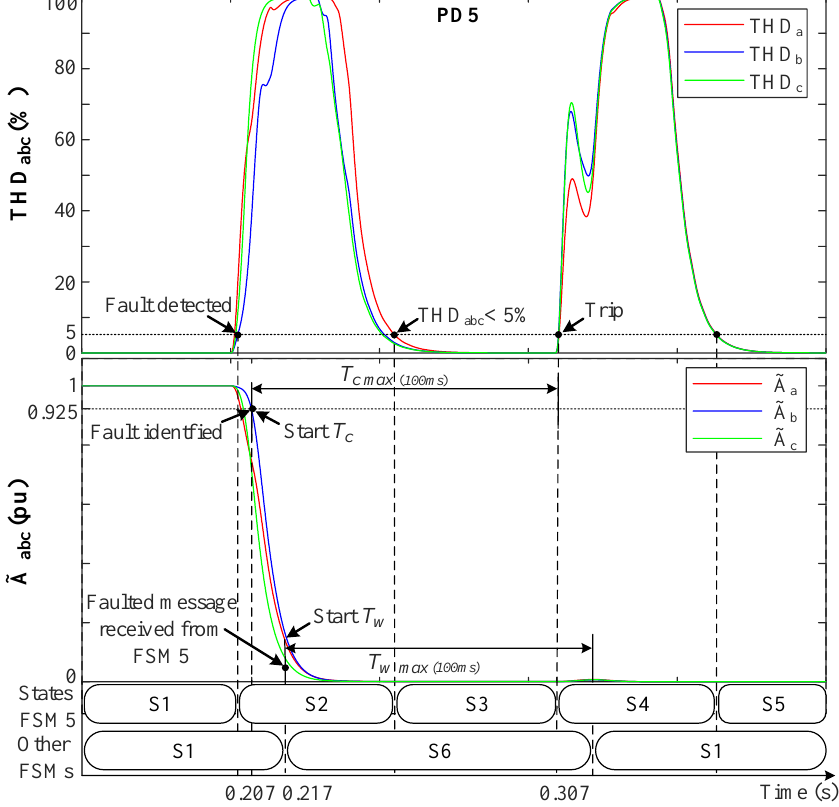
Figure 8. The system behavior with the FSMs during a 3PH-G fault at F3. ( Upper ) 𝑇𝐻𝐷 𝑎𝑏𝑐 . ( Lower ) 𝐴̃ 𝑎𝑏𝑐 .